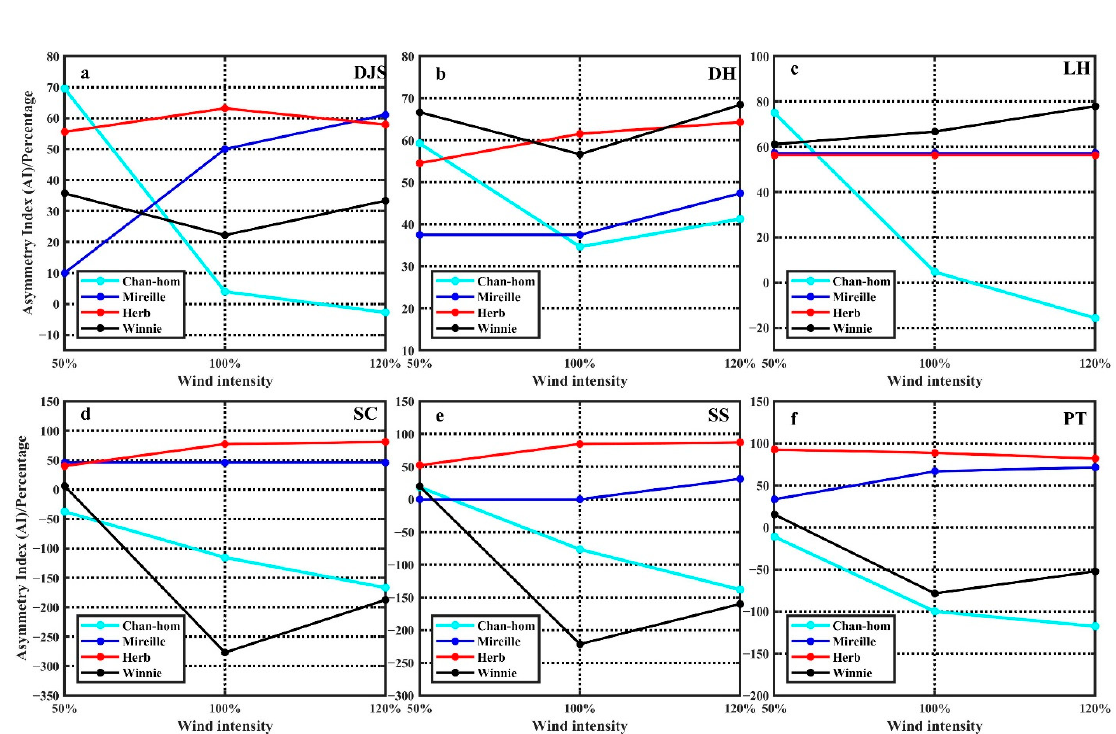
Figure 18. The relationship between asymmetry index and wind intensity with different paths at: ( a ) DJS, ( b ) DH, ( c ) LH, ( d ) SC, ( e ) SS, and ( f ) PT station.